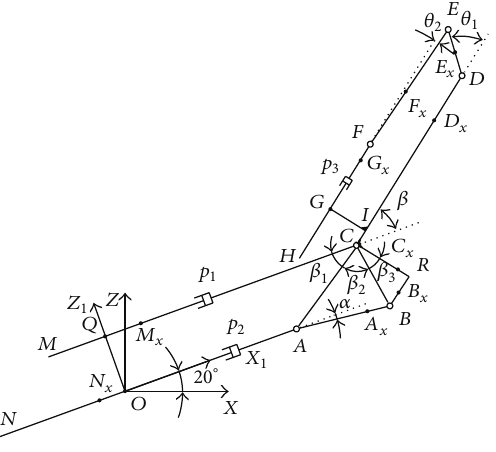
Figure 2: Structure of forearm in {𝑂 0 } and {𝑂 1 }